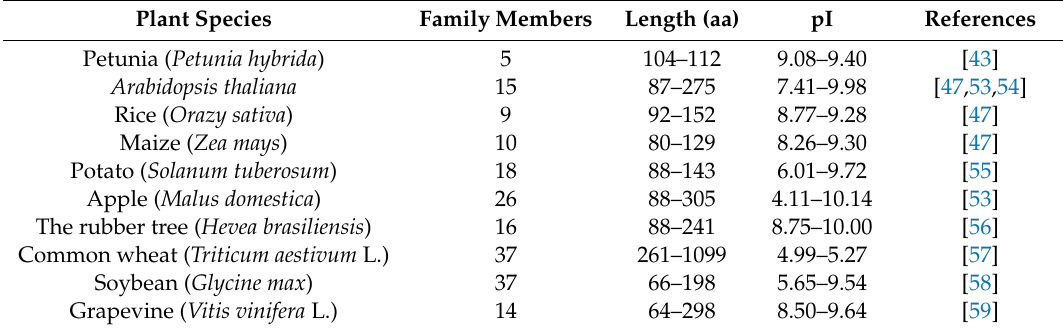
Table 1. Overview of the Snakin / GASA gene family in some selected plant